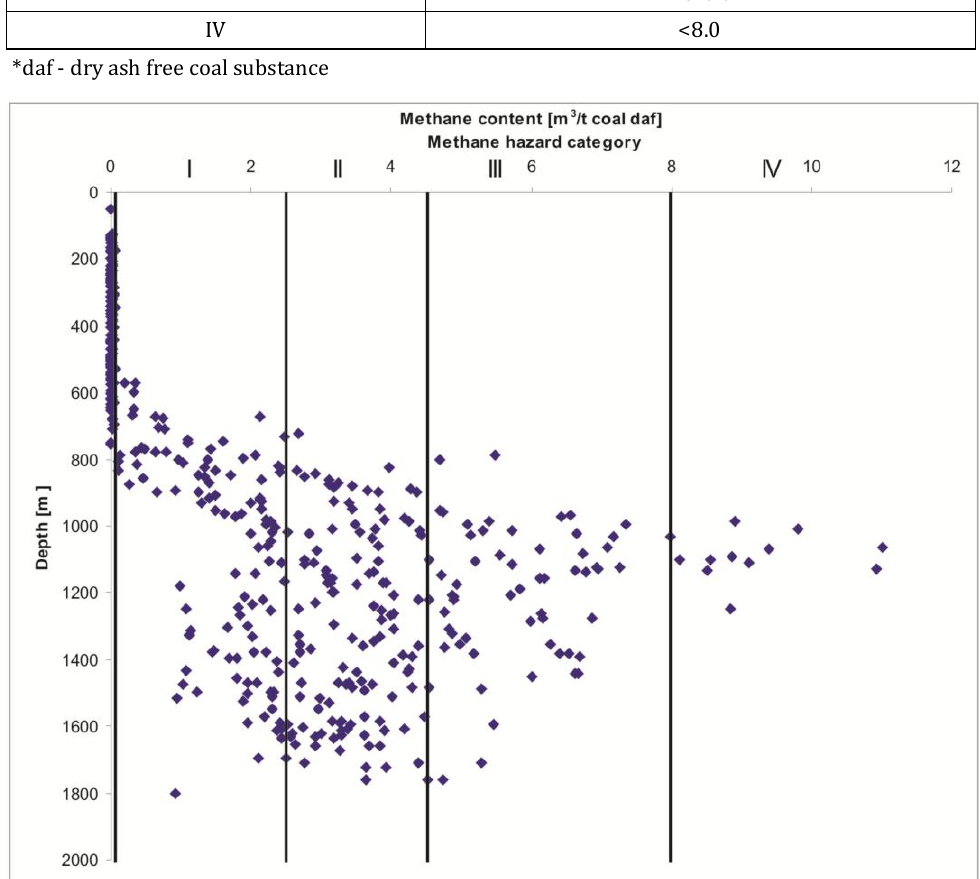
Fig. 2. Depth distribution of methane content and methane hazard categories in the coal mines of Katowice Coal Company (based on the data from bore-holes, the archive of Polish Geological Institute,